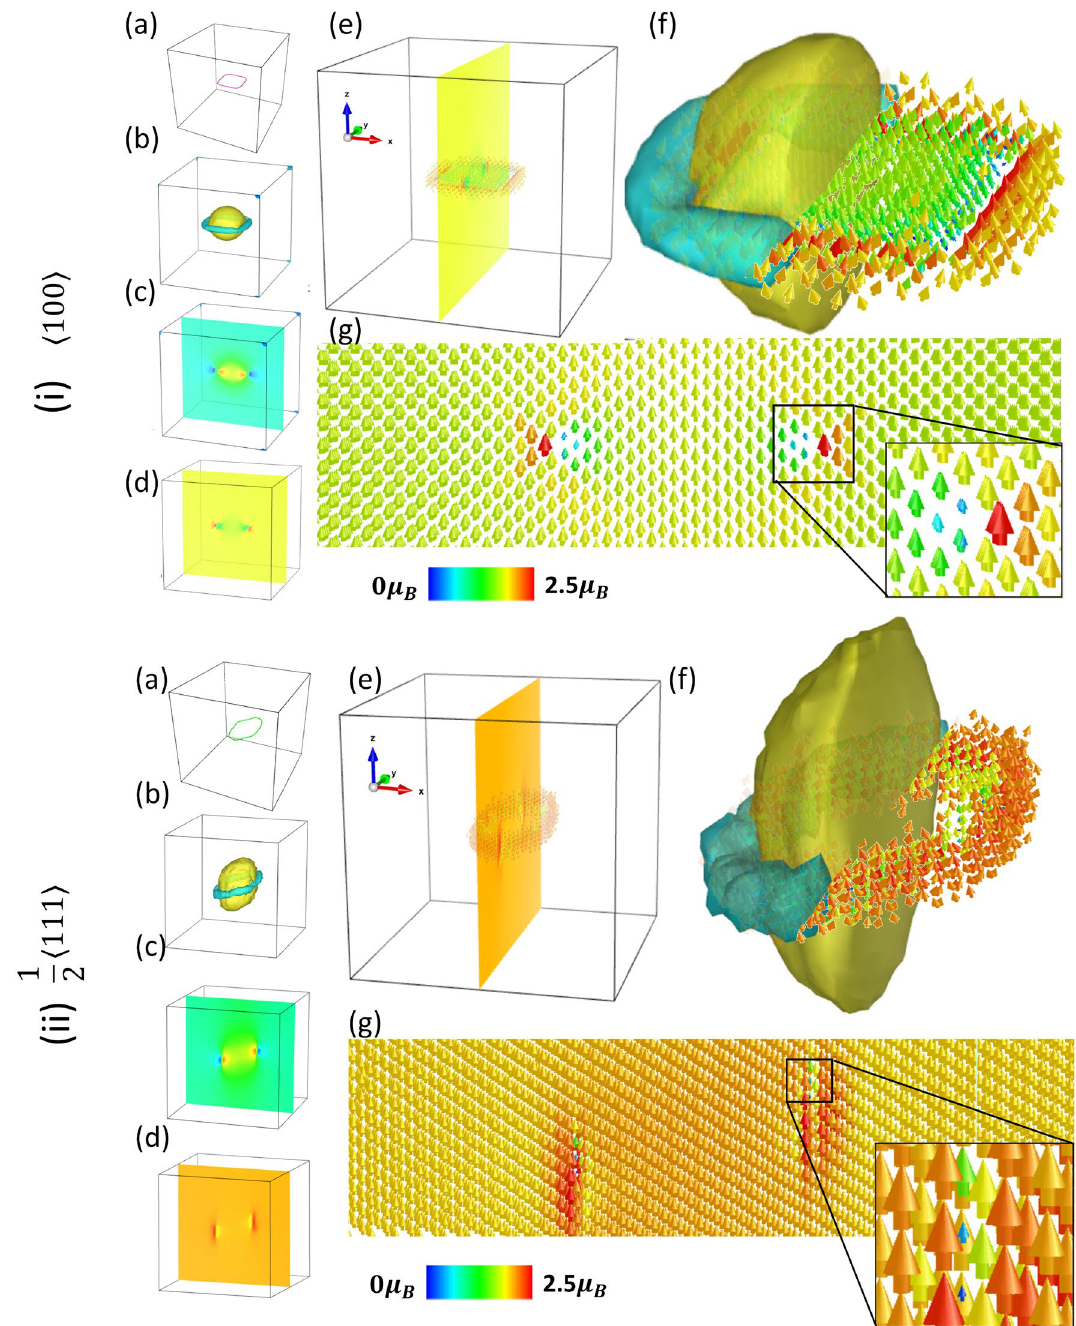
1 111 100 and (ii) interstitial 2 (cid:31) (cid:30) (cid:31) (cid:30)